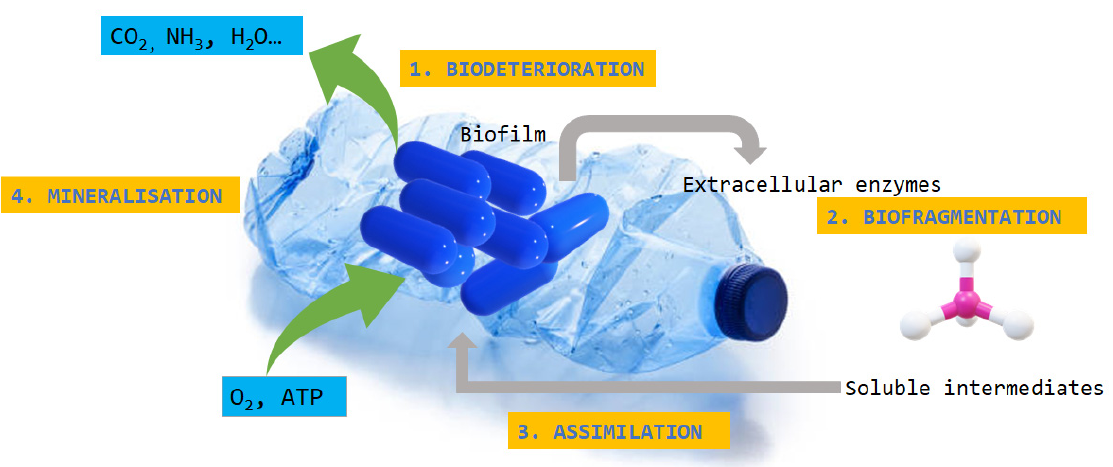
Figure 3. Different stages of plastic degradation by microorganisms. Deciphering different stages of microplastics by microorganisms reveals that different biochemical processes are involved in the event. Some of the events are action of extracellular enzymes, assimilation, mineralization, bio ‐ deterioration, etc.